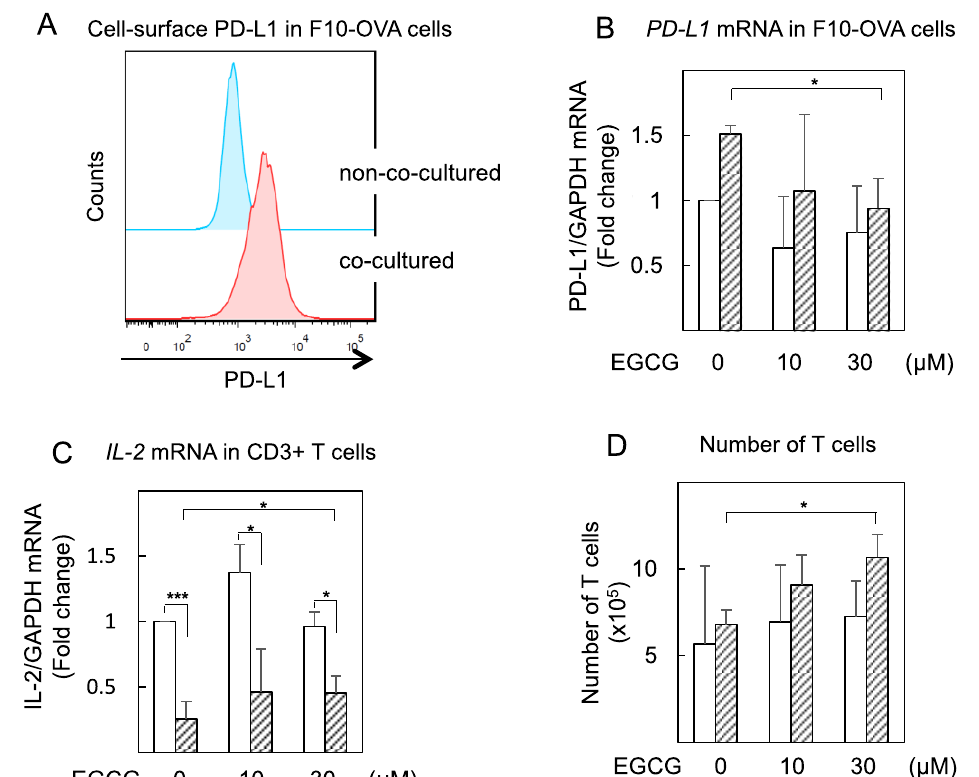
Figure 5. EGCG reduced PD-L1 mRNA expression in co-cultured F10-OVA cells and restored IL-2 mRNA expression in co-cultured tumor-specific CD3+ T cells. ( A ) Cell-surface PD-L1 and ( B ) PD-L1 mRNA in F10-OVA cells alone (open bars) and cells co-cultured with CD3+ T cells (shaded bars). mRNA expression normalized by GAPDH in nontreated cells is expressed as 1 in ( B ) and ( C ). ( C ) IL-2 mRNA in CD3+ T cells alone (open bars) and cells co-cultured with F10-OVA cells (shaded bars). ( D ) Number of T cells in CD3+ T cells alone (open bars) and cells co-cultured with F10-OVA cells (shaded bars) were counted by trypan blue exclusion method. * p < 0.05, *** p < 0.001.